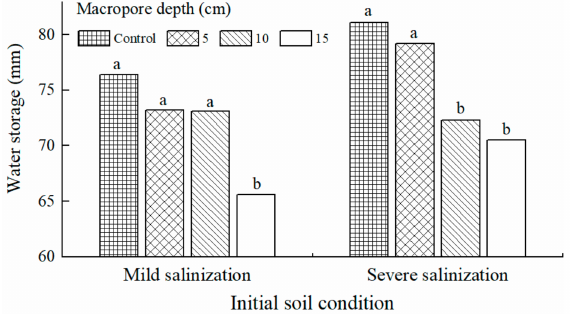
Figure 4. Mean water storage in top 30 cm soil layer 25 days after irrigation under different macropore depth treatments for artificial macropores with sandy fillings (AMSF) method. Control means soils without macropore. Mean values within same initial soil condition followed by different letters are significantly different ( p =